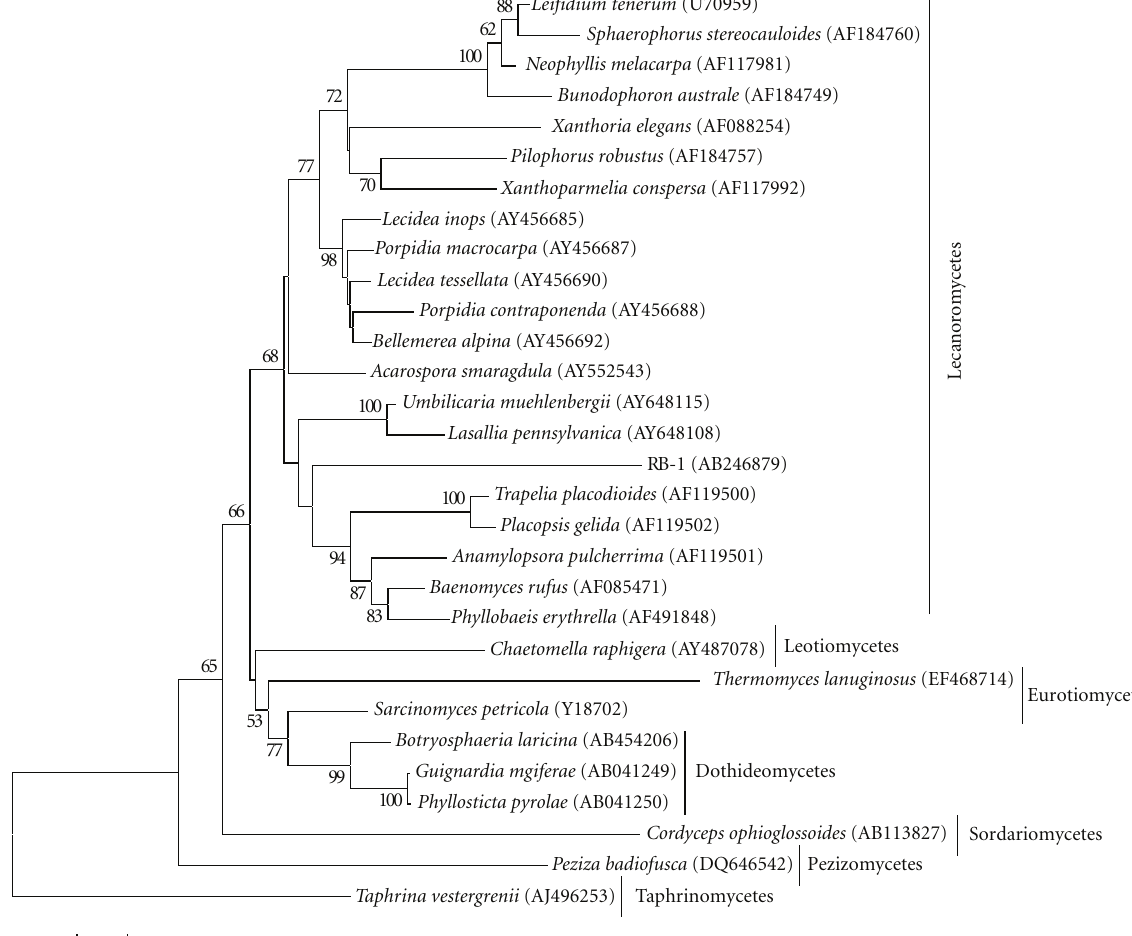
Figure 2: Phylogenetic tree for RB-1 constructed by the neighbor-joining method on the basis of the SSU rDNA sequences retrieved from the DDBJ/GenBank/EMBL databases. DDBJ/GenBank/EMBL accession numbers of retrieved sequences are indicated in parentheses. The Bootstrap values based on 1000 replications are given on the nodes as percentages above 50%. Taphrina vestergrenii was used as the outgroup. Bar: 0.005 substitutions per nucleotide